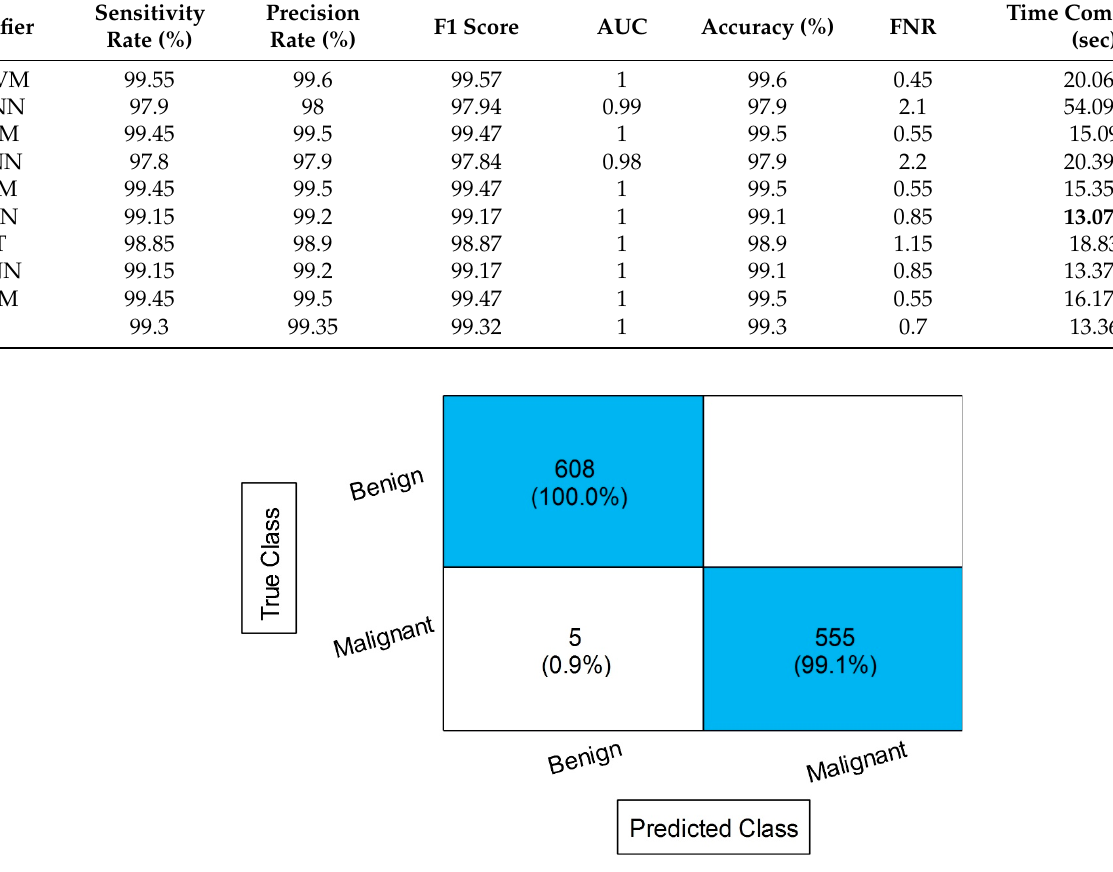
Figure 12. Confusion matrix MGSVM after employing proposed feature fusion. Table 9. Classification results of proposed feature selection technique on INbreast